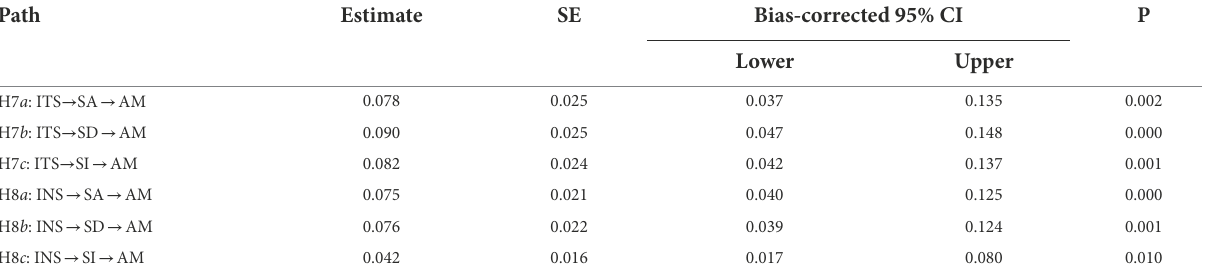
TABLE 6 Mediating effect testing